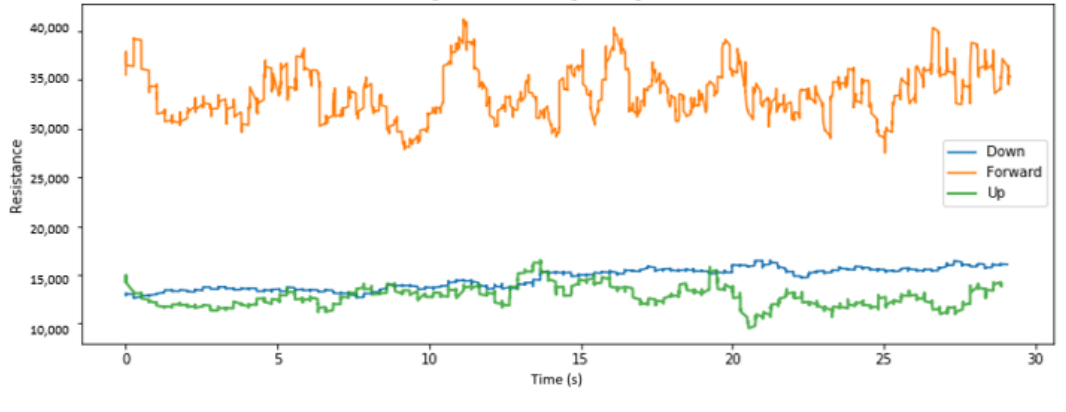
Figure 7. With long sensor, head tilt filtered data.